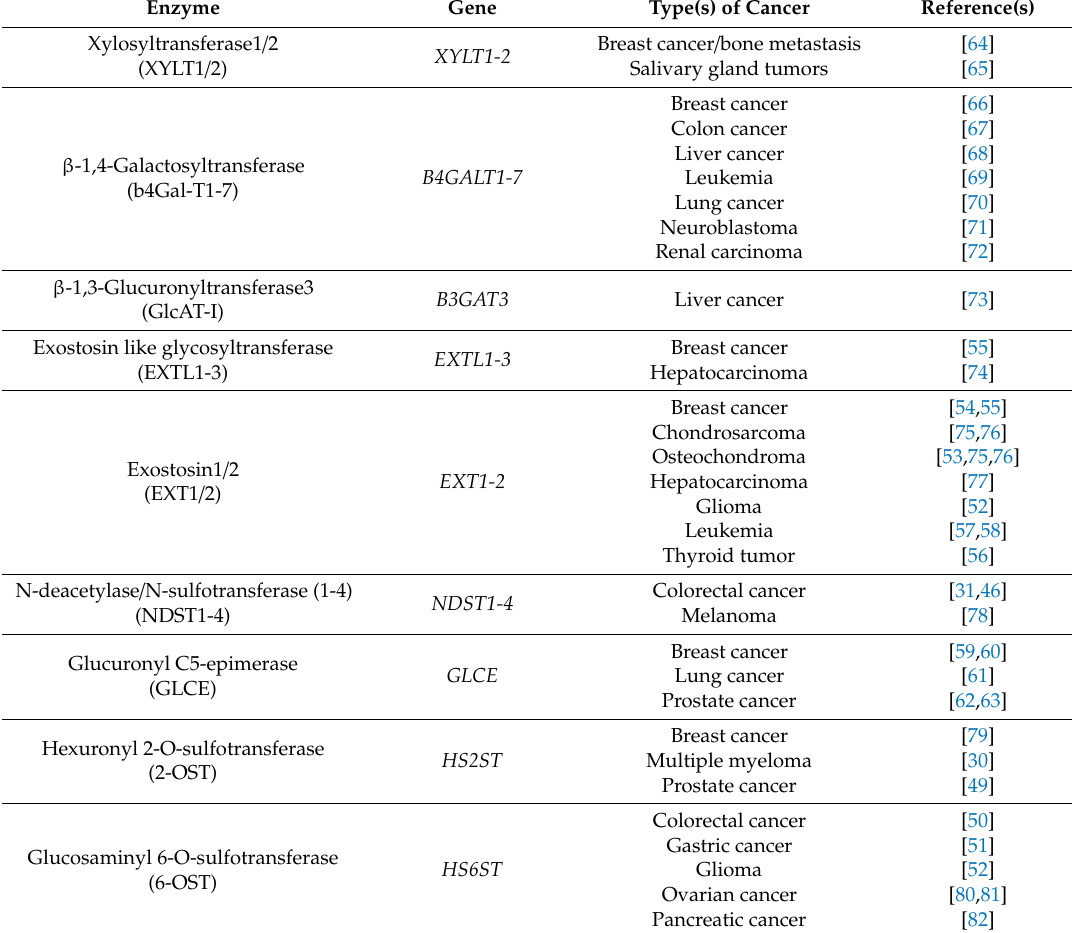
Table 2. HS biosynthetic and modifying enzymes involved in cancer development and